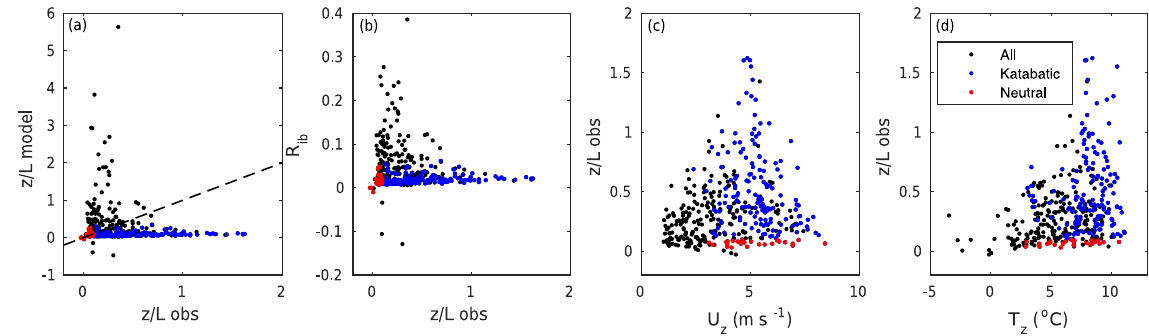
Figure 7. (a) Modeled z/L with the fixed-point iterative scheme in the C M − O method against the OPEC-derived stability parameter ( z/L obs ), and (b) Bulk Richardson number ( Ri b ) against z/L obs . Dashed black line shows 1:1 line. (c) Dependency of z/L obs on the measured wind speed ( U z ) and (d) on the near-surface air temperature ( T z ). Red (blue) points show values during near-neutral (katabatic) flow